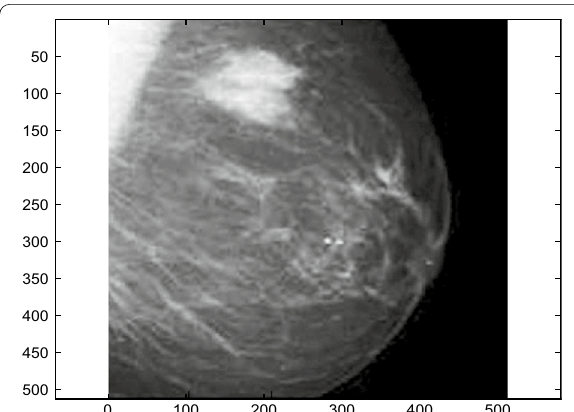
Fig. 2 The input mammographic image used in the processing. It is represented by a matrix of dimensions 512 512 pixels starting from × (0, 0) in the upper left corner. The following images shown in Figs. 3, 4, 5, 6 and 7 have the same dimensions as the input image